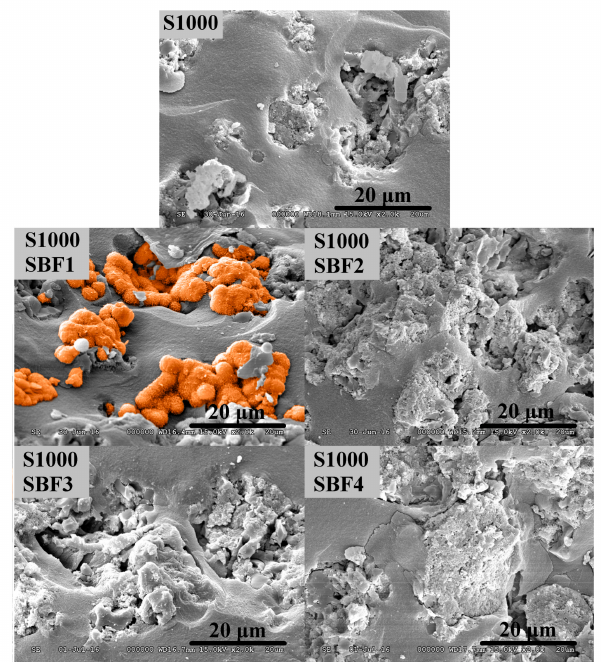
Figure 2. SEM micrographs of the untreated surface of the sample S1000 (top picture) and after soaking in the four types of simulated body fluids. The typical cauliflower-like structure of deposited HA can be seen only on the surface of S1000 treated in SBF1 (orange colored, similar to the ones found in the literature [50–53]).